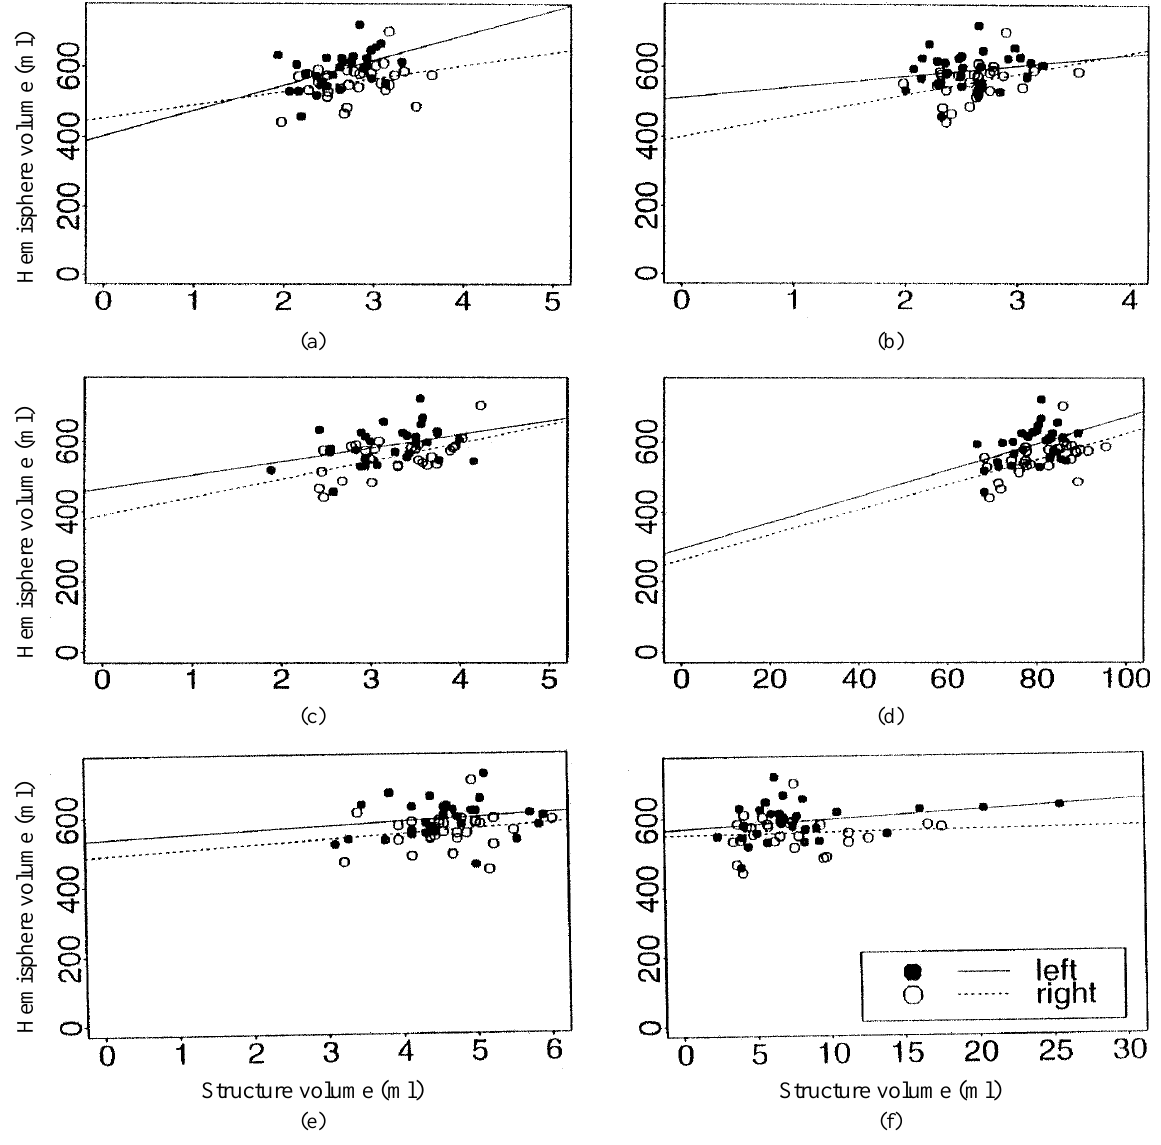
Fig. 3. Relationship between the volumes of the right and left (a) hippocampus, (b) amygdala, (c) parahippocampal gyrus, (d) temporal lobe, (e) caudate nucleus and (f) lateral ventricle and the volume of the respective cerebral hemisphere. examined for these eighteen subjects using the same statistical methods as for stage 1. The results are pre- sented in Table 6. No significant correlations were found between performance in FRM Test B and either the absolute volumes or the proportional volumes of the measured brain structures. There was, however, a significant correlation between the ratio of the left to the right temporal pole volume and FRM perfor- mance. This indicates that the smaller a subjects’ right temporal pole was relative to their left temporal pole,